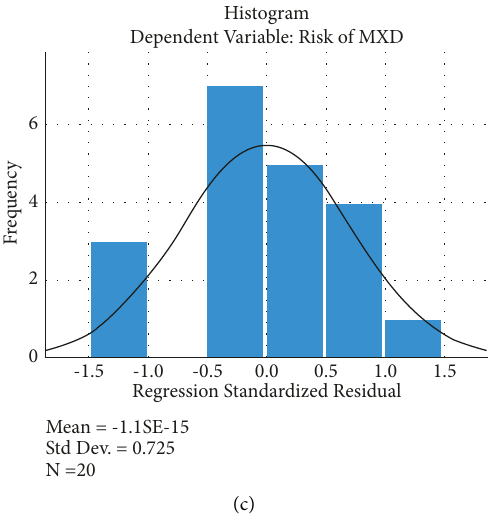
Figure 8: Residual statistics showing the graphs A B, and C are not skewed in any direction for AD, VD, and MXD. Periventricular